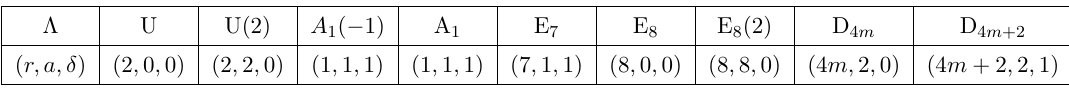
sublattices of ( r − 1 , 1)